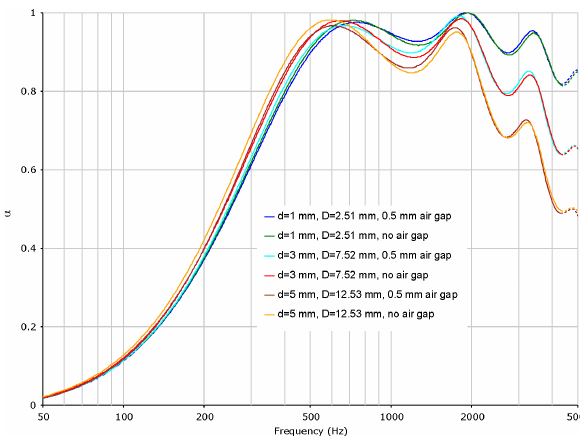
Figure 17: Influence of the hole diameter ( σ = 12.5 %, t = 1 mm)